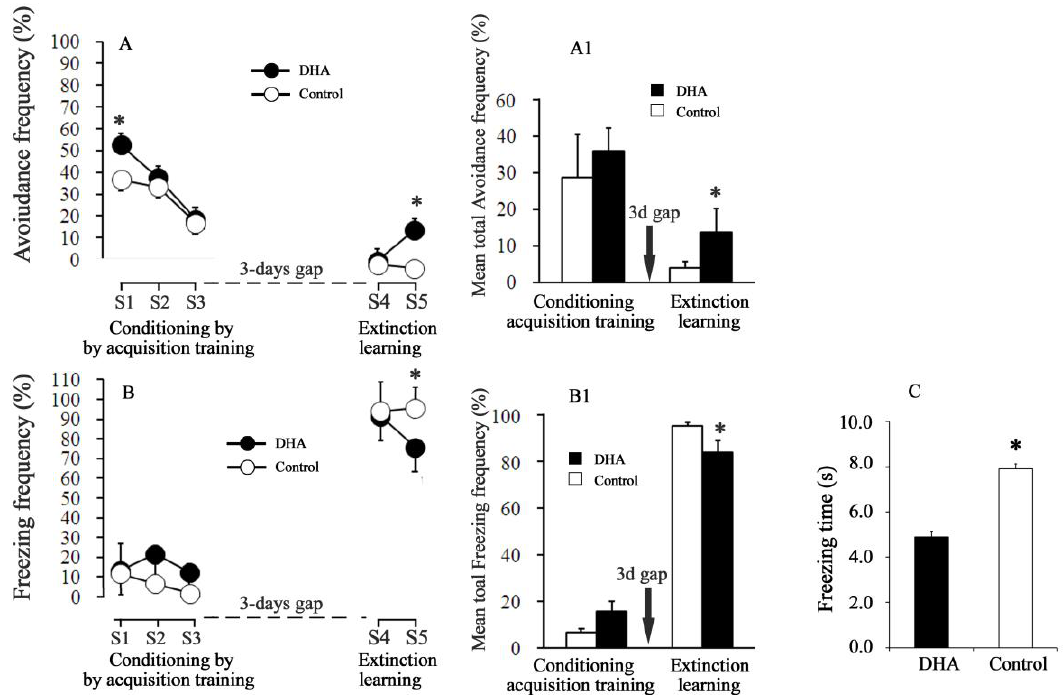
Figure 1. Effects of docosahexaenoic acid (DHA) on fear avoidance ( A ) and freezing responses. ( B) Freezing frequency in the acquisition trials (S1, S and S3) and extinction trials [session4 (S4)